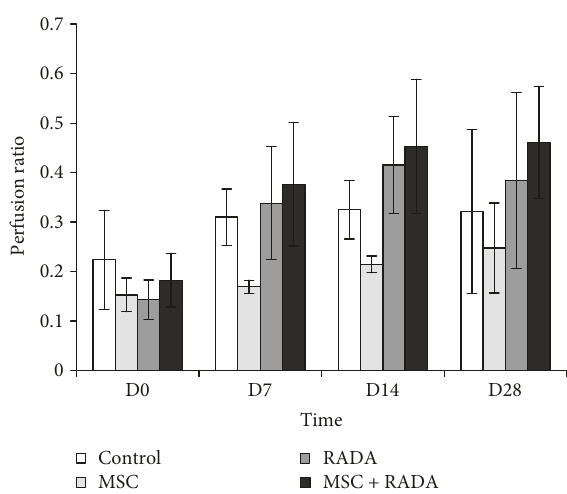
Figure 4: Quanti fi cation of hindlimb perfusion by a laser Doppler perfusion measuring system for MSCs, RADA, MSCs+ RADA, and control, demonstrating a tendency for better perfusion in the MSC+ RADA combination group compared to MSCs or RADA alone, although not statistically signi fi cant due to the high variability of the measuring system